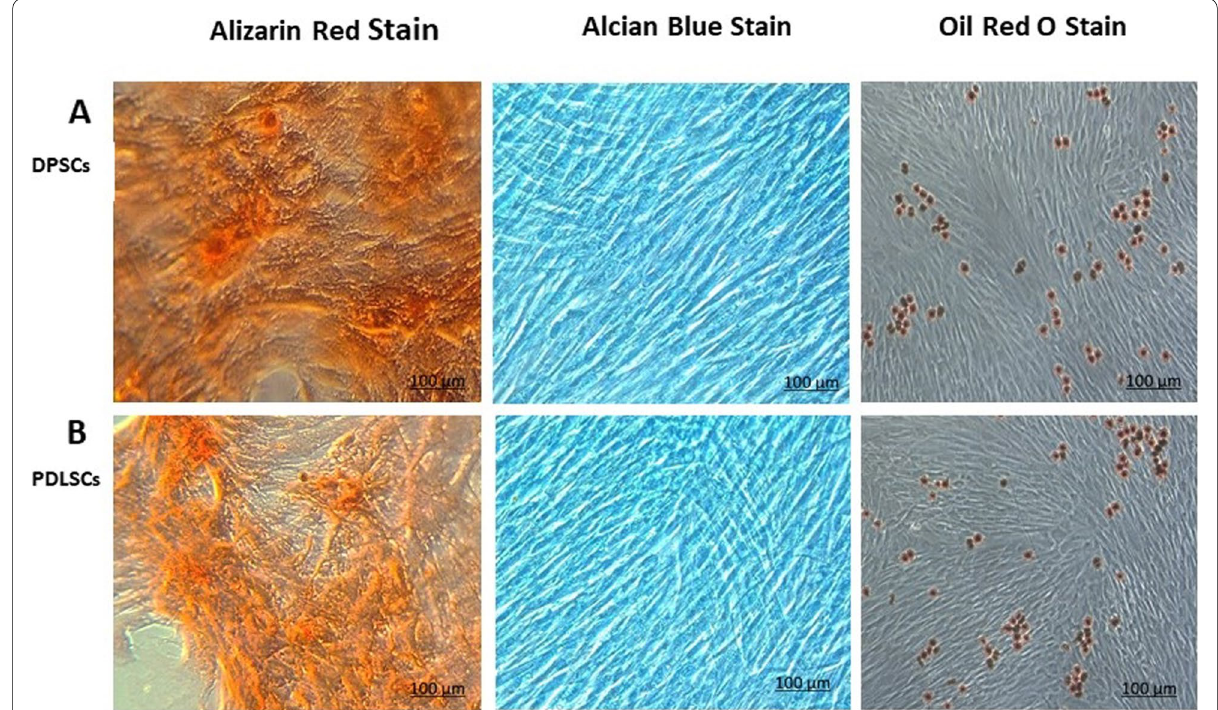
Fig. 4 Multi‑lineage differentiation of hDPSCs ( A ) and hPDLSCs ( B ). In order to confirm the stem cell identity of the isolated cells from dental pulp and periodontal ligament, multi‑lineage differentiation potential of those cells into adipogenic, chondrogenic, and osteogenic lineages was assessed. Osteogenic differentiation of hDPSCs & hPDLSCs was evaluated by Alizarin red staining. Cells assumed a polygonal shape indicating successful differentiation and also dark orange stains indicating nodules of calcification were demonstrated in both groups (left). Chondrogenic differentiation of DPSCs & PDLSCs was assessed by Alcian Blue staining (middle). Cells demonstrated morphology similar to chondrocytes rather than the typical spindle‑shaped appearance of stem cells. Blue staining was demonstrated indicating the presence of sulfated glycosaminoglycans by differentiated chondrocytes. Adipogenic differentiation of hDPSCs and hPDLSCs was confirmed by Oil Red O staining (right) and demonstrated lipid droplets in differentiated cells. Accumulation of intracellular lipid droplets can be seen scattered denoting successful differentiation (scale bar